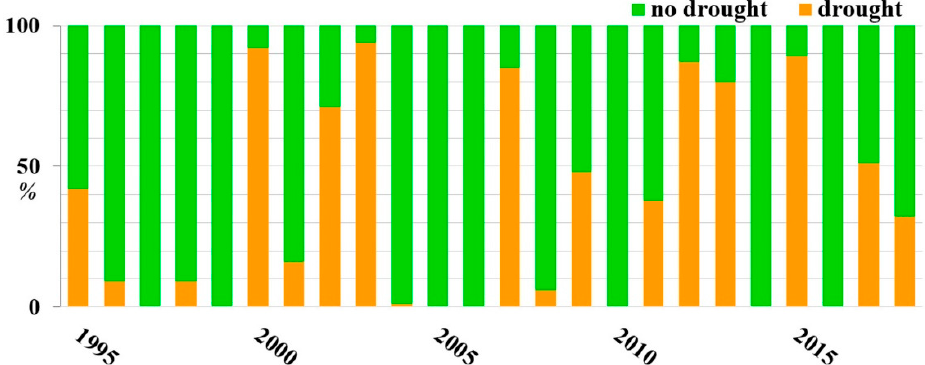
Figure 3. Proportion of areas a ff ected by drought in Hungary from 1995 to 2018; based on data [29].